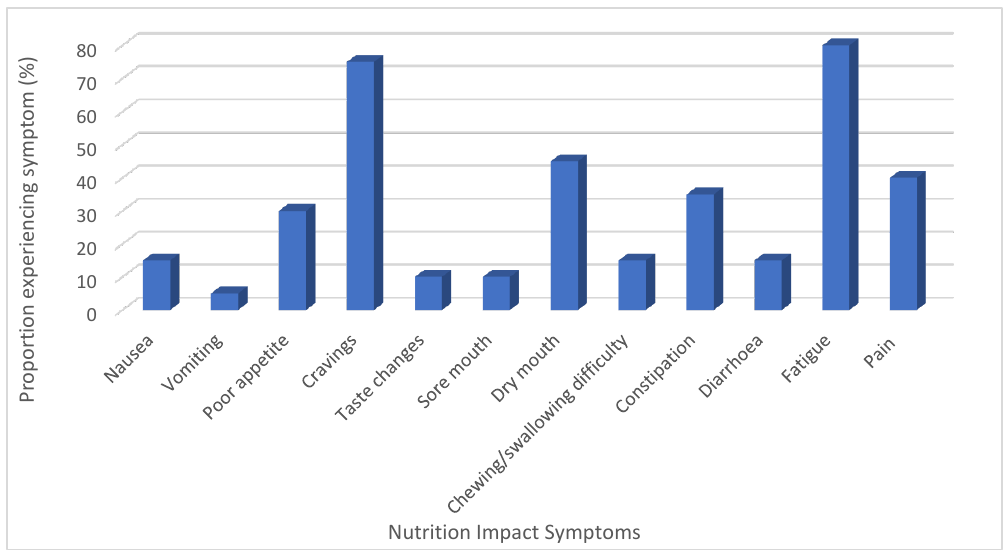
Figure 3. % of participants who reported experiencing nutrition impact symptoms .